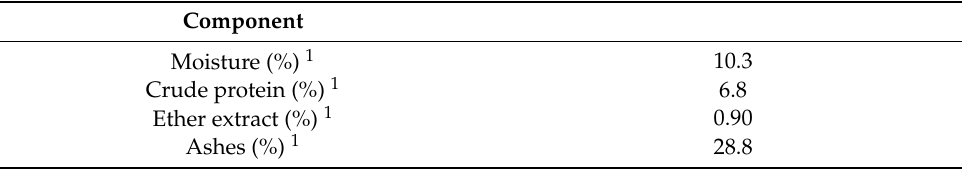
Table 1. Composition of banana pseudo-stem